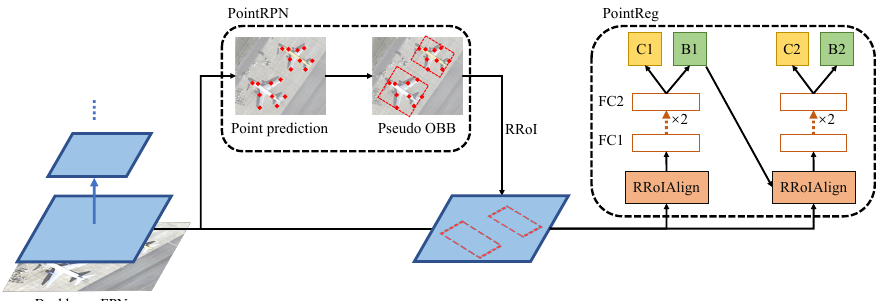
Figure 3. The overall pipeline of the proposed angle-free Point RCNN framework for rotated object detection. Point RCNN mainly consists of two modules: PointRPN for generating rotated proposals, and PointReg for refining for more accurate detection. “RRoI” denotes rotated RoI, “FC” denotes fully-connected layer, “C” and “B” represent the predicted category and rotated box coordinates of each RRoI,